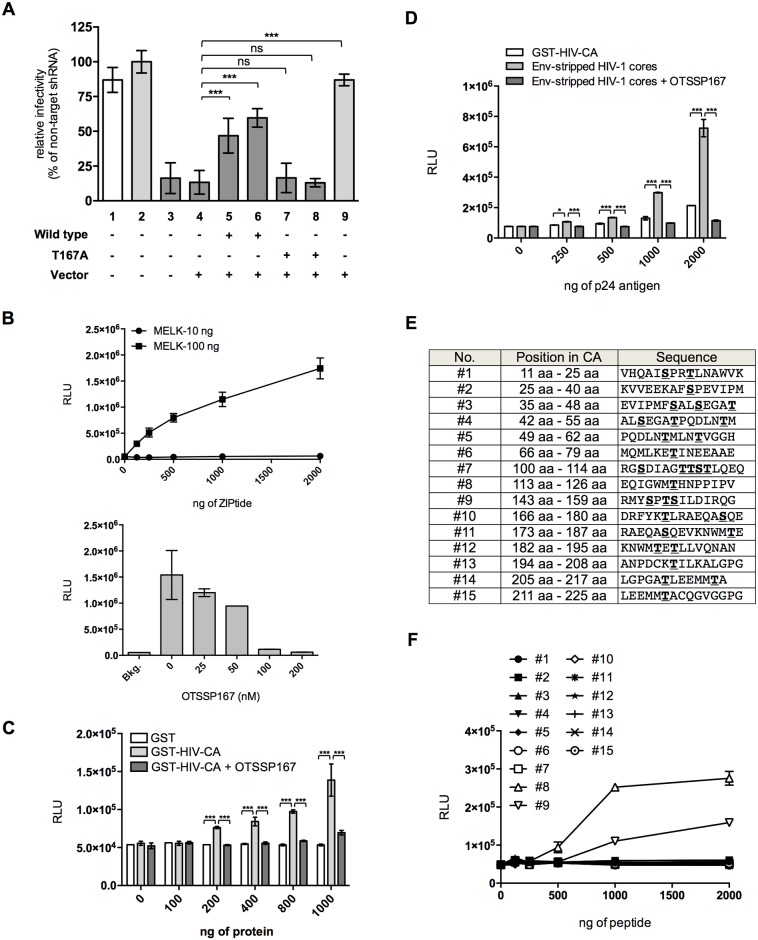
Catalytic activity of MELK is required for HIV-1 infection.(A) Effect of exogenous wt or T167A MELK on single-round HIV-1 infection. VSV-G-pseudotyped NL4-3luc was used to infect parental MT4C5 (white bar: lane 1), Non-T (gray bars: lanes 2 and 9) and MELK-KD-1 (dark gray bars: lanes 3 to 8) cells transduced with control vector (lane 4), wild-type MELK (lanes 5 and 6) or catalytically inactive T167A MELK mutant (lanes 7 and 8) (see also S7 Fig). Two independent MELK-KD-1 cell pools expressing wild-type MELK (lanes 5 and 6) or T167A MELK mutant (lanes 7 and 8) were used. Error bars indicate the standard deviations calculated from five independent experiments. (B)
In vitro luminescent kinase assay with recombinant active MELK (10 or 100 ng) and increasing amounts of ZIPtide, a substrate for MELK (upper panel). Phosphorylation of the substrate was monitored as the amount of ADP produced during the kinase reaction. Effect of OTSSP167, a MELK kinase inhibitor, on in vitro MELK kinase activity (lower panel). Error bars indicate the standard deviations calculated from three independent experiments. (C)
In vitro luminescent kinase assay with recombinant active MELK and increasing amounts of the indicated GST fusion proteins in the presence or absence of OTSSP167 (100 nM). Mean values from five independent experiments are shown. Error bars indicate the standard deviations calculated from five independent experiments. (D)
In vitro luminescent kinase assay with recombinant active MELK and increasing amounts of the indicated substrates in the presence or absence of OTSSP167 (100 nM). Phosphorylation of proteins was monitored as in (C). Error bars indicate the standard deviations calculated from five independent experiments. (E) List of fifteen different peptides containing serine or threonine residues in HIV-1 CA. (F)
In vitro luminescent kinase assay with recombinant active MELK and increasing amounts of each peptide shown in (E). Phosphorylation of the peptides was monitored as in (B). Experiments were performed at least three times and error bars are standard deviations calculated from three independent experiments. Statistical significance was determined by one-way analysis of variance (ANOVA) with Dunnett’s multiple comparison test (A), or two-way ANOVA with Tukey’s multiple comparison test (C and D). ns, not significant (P>0.05); *P<0.05, **P<0.01, ***P<0.001.